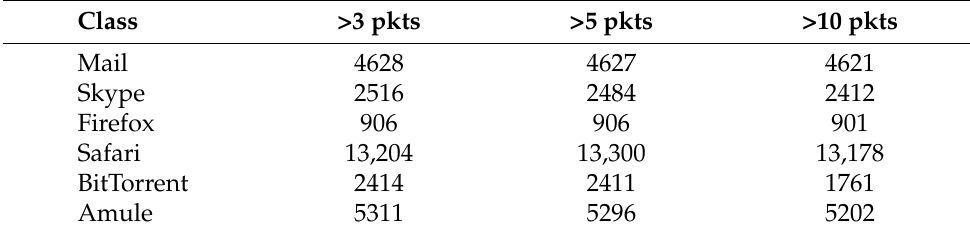
Table 1. UniBS data set: number of instances per each class.